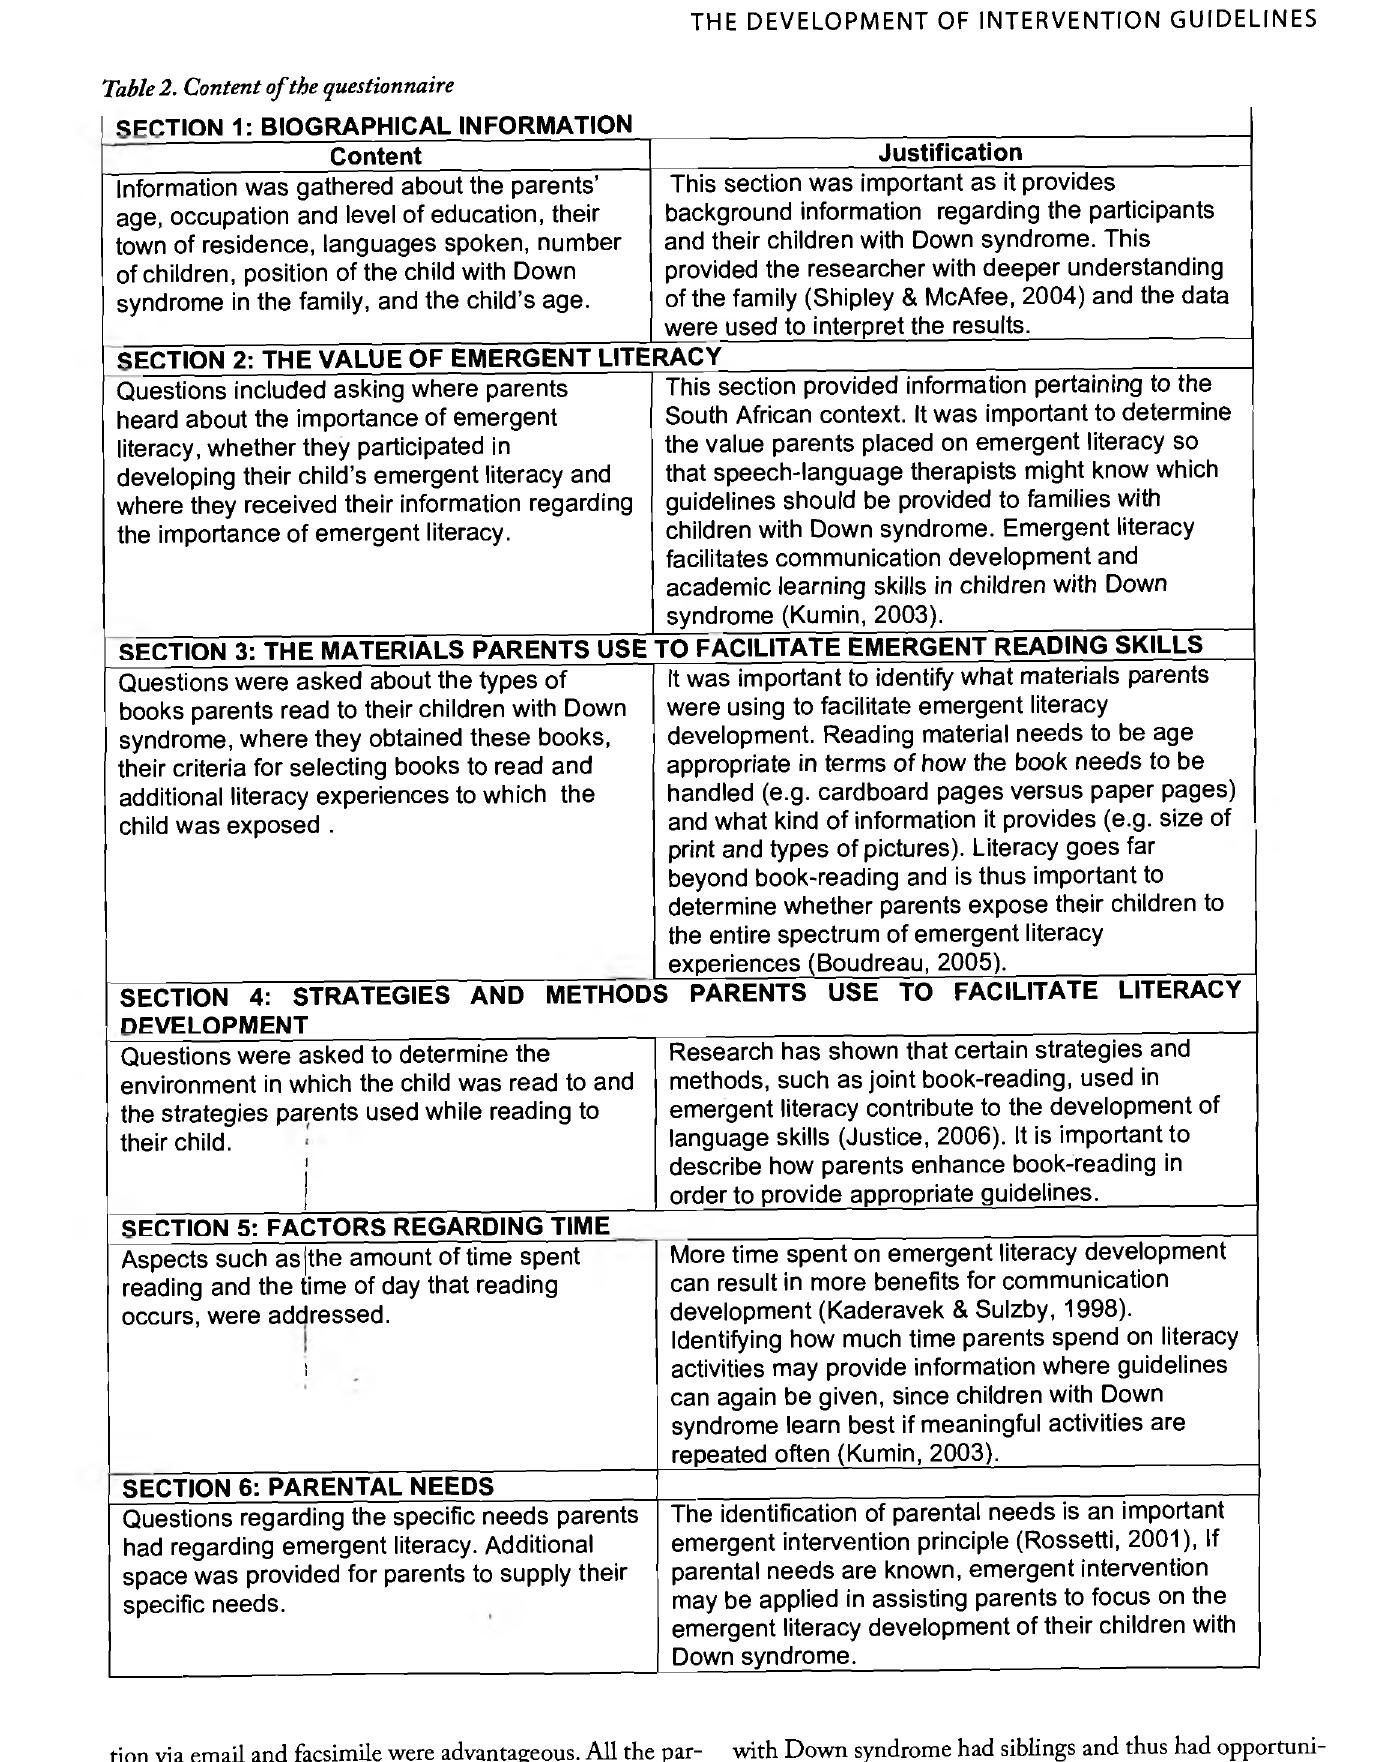
Table 2. Content o f the questionnaire SFCTION 1: BIO G RAPHICAL INFORM ATIO